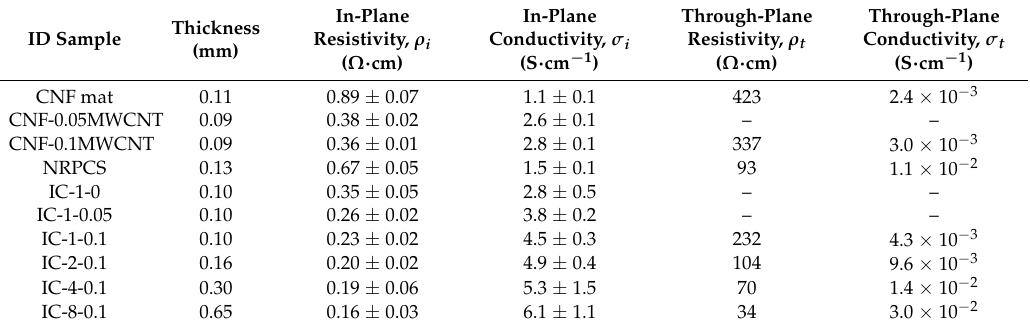
Table 2. Values of in-plane and through-plane electrical resistivity/conductivity of produced composites. ID